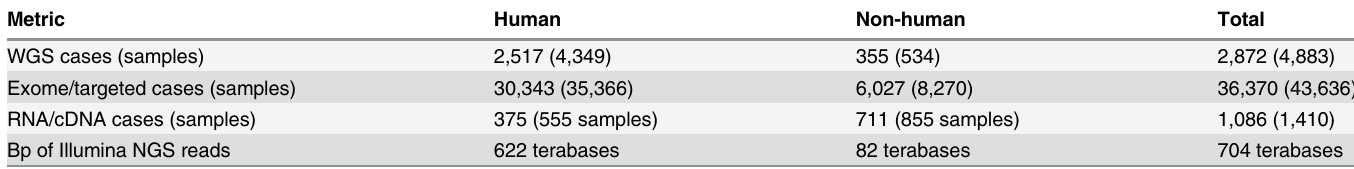
Table 2. Data processed by the GMS. A brief summary of data processed by use of the GMS at The Genome Institute of Washington University School of Medicine in St. Louis (as of October 2014).